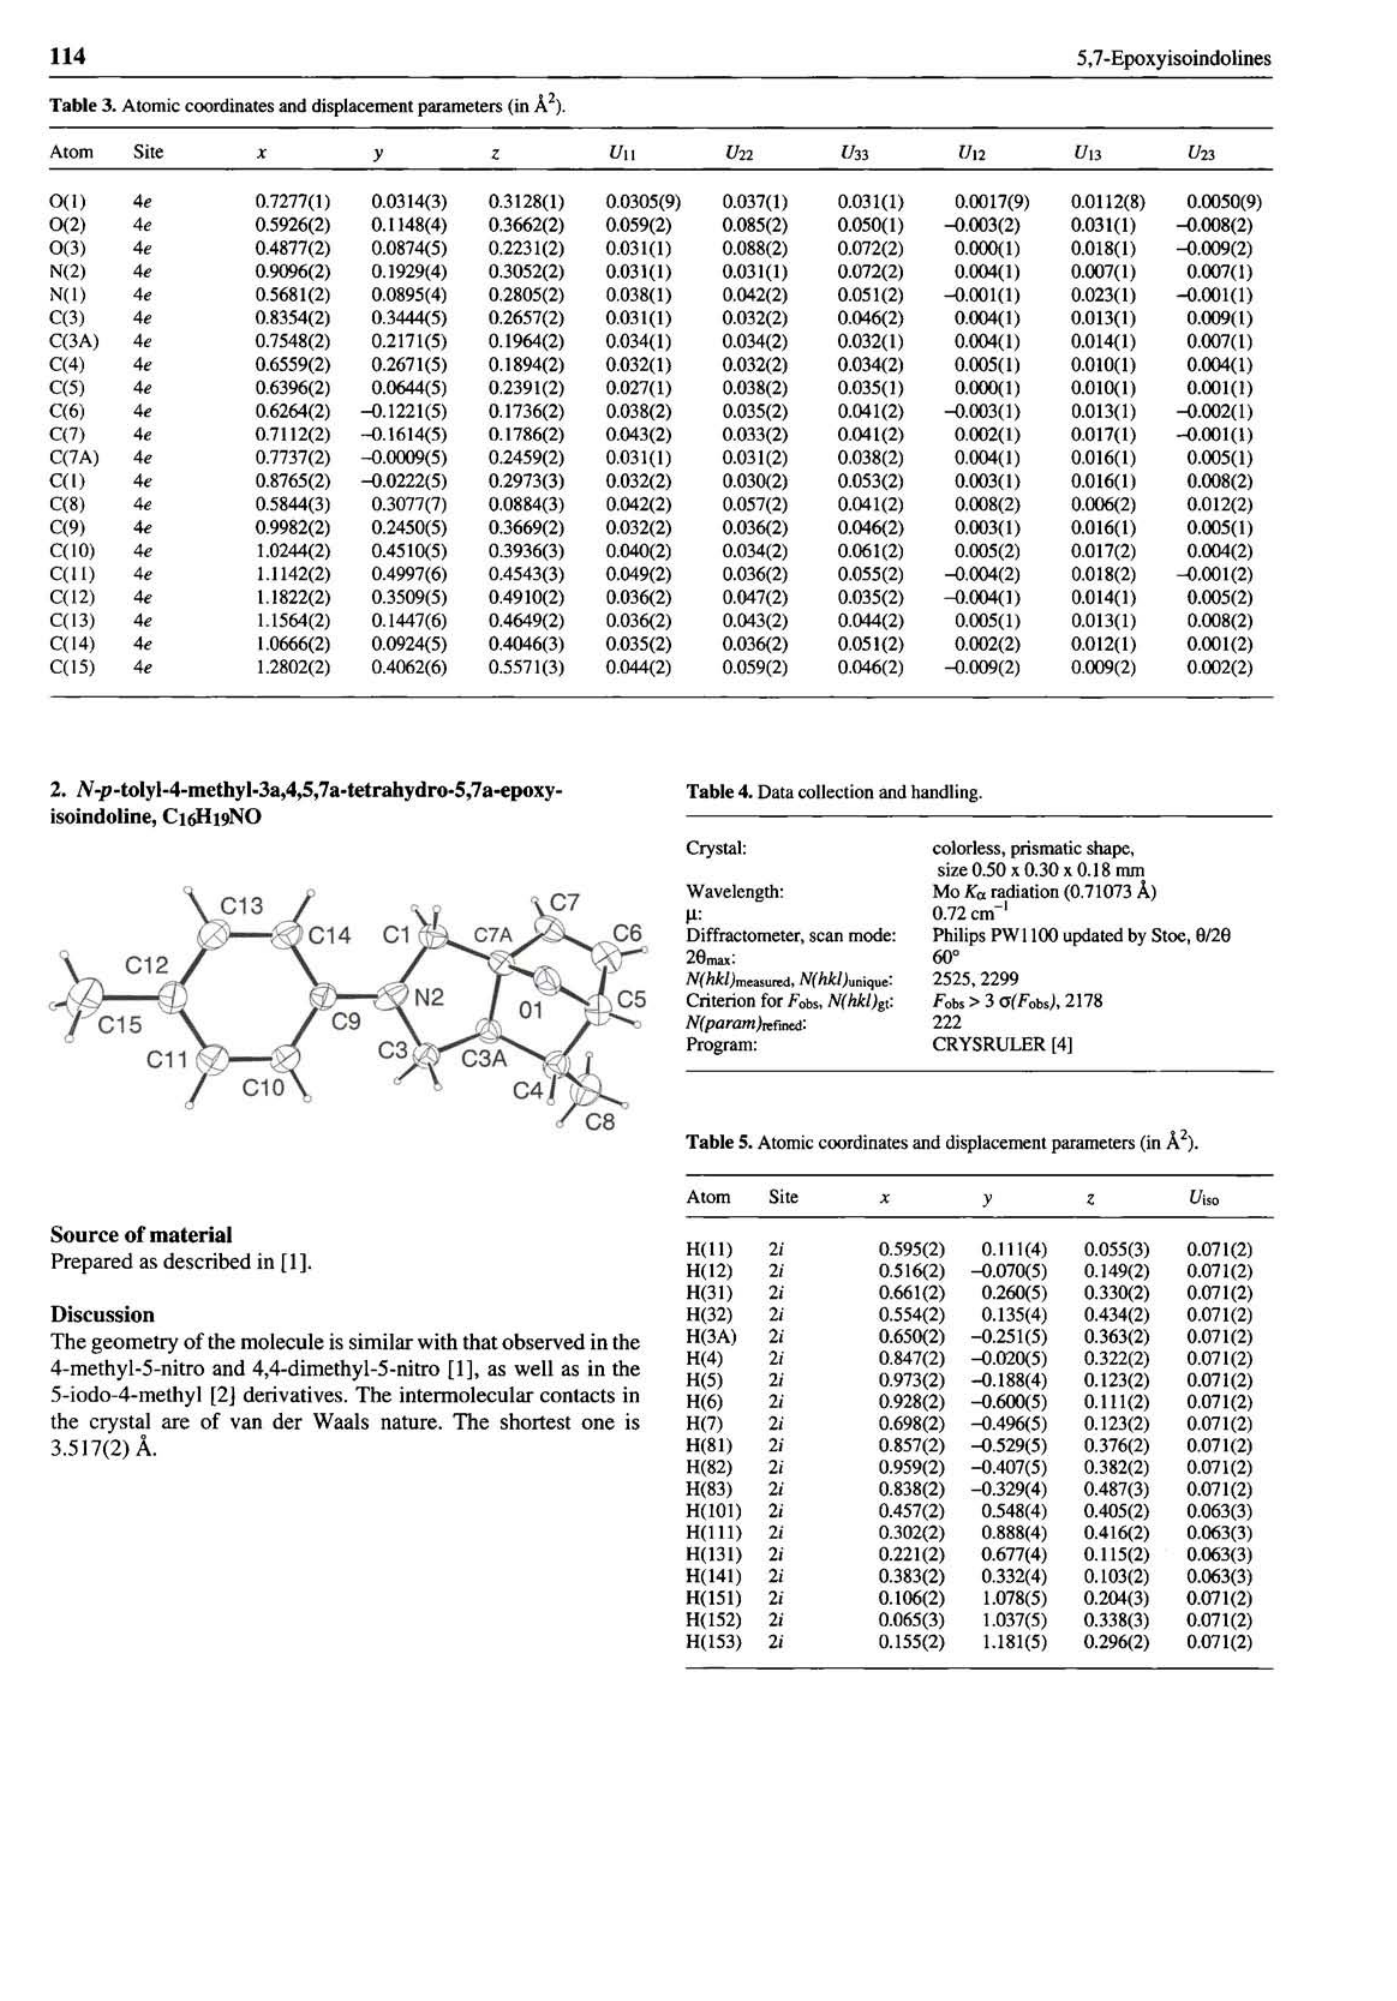
Table 3. Atomic coordinates and displacement parameters (in À 2 ).